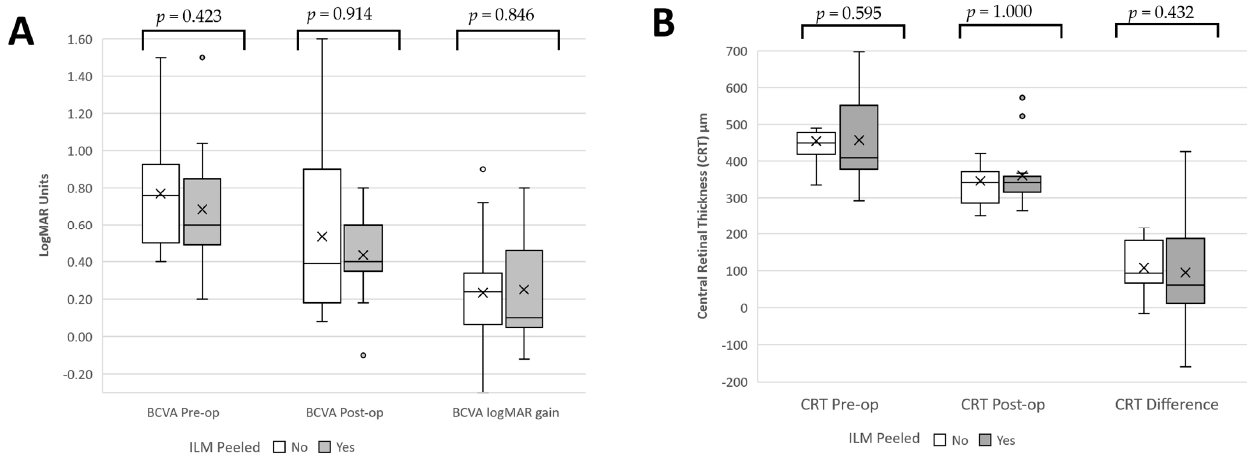
Figure 2. Effect of Internal Limiting Membrane peel on central retinal thickness and visual acuity in uveitic ERM peels at six-months. CRT: Central Retinal Thickness, ILM: Internal Limiting Membrane, ERM: Epiretinal Membrane, BCVA: Best Corrected Visual Acuity. CRT difference = Pre-operative CRT—Post-operative CRT. X denotes mean. Boxplot and whiskers are median and interquartile range. ILM peeling was not found to contribute any difference in ( A ) improvement in CRT or ( B ) logMAR Gain.